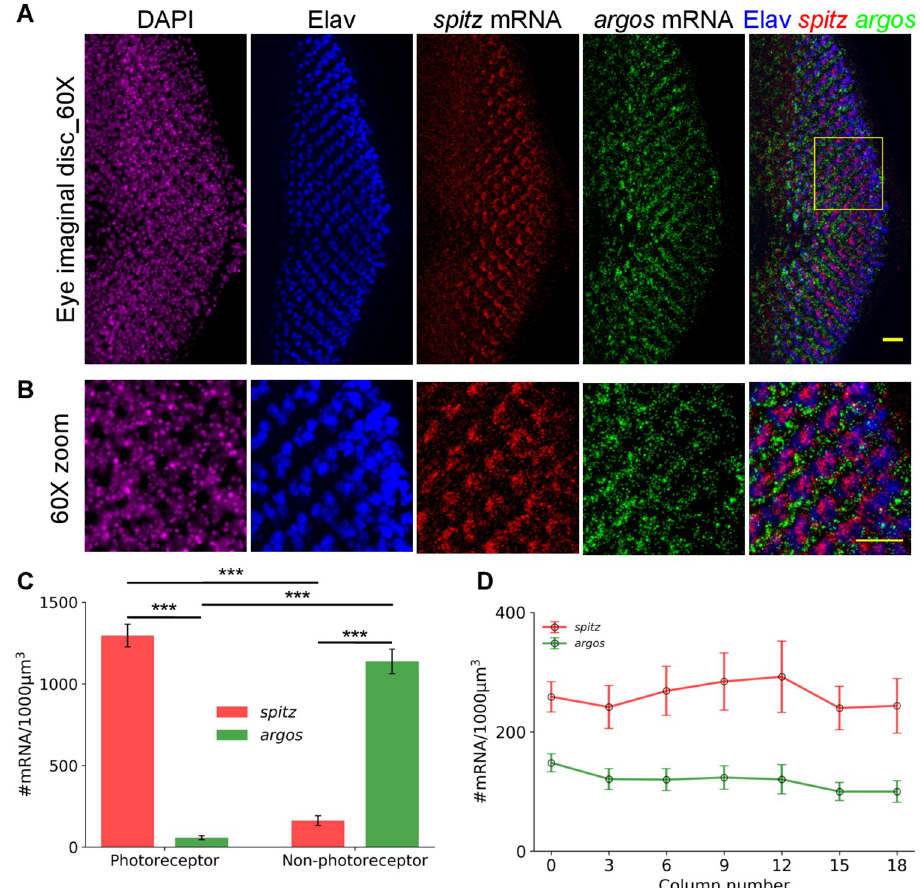
Fig 1. EGFR signaling is directional in the eye imaginal discs. ( A) 60X images of 3 rd instar eye imaginal discs stained with DAPI, Elav (Immunofluorescence; pan-neuronal marker), spitz mRNA and argos mRNA (single molecule RNA FISH). spitz mRNA is highly expressed only in the Elav-positive photoreceptor cells, whereas argos mRNA is highly expressed in the neighbouring non-neuronal cells. To clearly see the exclusive expression of spitz and argos , the image is zoomed into the yellow box and presented in (B). Scale bar is 10 μ m in (A) and 5 μ m in (B). These are z-projected images and hence individual transcripts get merged. A single z-slice is shown in S1B Fig. (C) The individual transcript molecules are counted in 3D using the StarSearch software (https://www.seas.upenn.edu/~rajlab/StarSearch/launch. html). The respective counts are represented per 1000 μ m 3 of tissue volume as individual cells are hard to segment in this dense tissue. Photoreceptor (PR) and non-photoreceptor (non-PR) cells are identified by nuclei position corresponding to Elav as shown in S2A Fig. spitz expression is significantly higher in PR cells compared to non-PR cells whereas argos expression is significantly higher in non-PR cells compared to PR cells. ( ��� indicates p- values < 0.001 in a Student’s t-test) (N = 9 tissues) (D) The mRNA counts are also represented in each photoreceptor column along a line from morphogenetic furrow (column 0) to the posterior end of the eye imaginal disc, as indicated in S2C Fig. (N = 8 tissues), irrespective of cell type (PR or non-PR)–overall mRNA counts are relatively constant along the line, i.e., with time after photoreceptor specification. Error bars in (C) and (D) are standard errors of mean. The images within the figure panels are created by the authors. Asterisks denoting significance of observed changes have been added to relevant